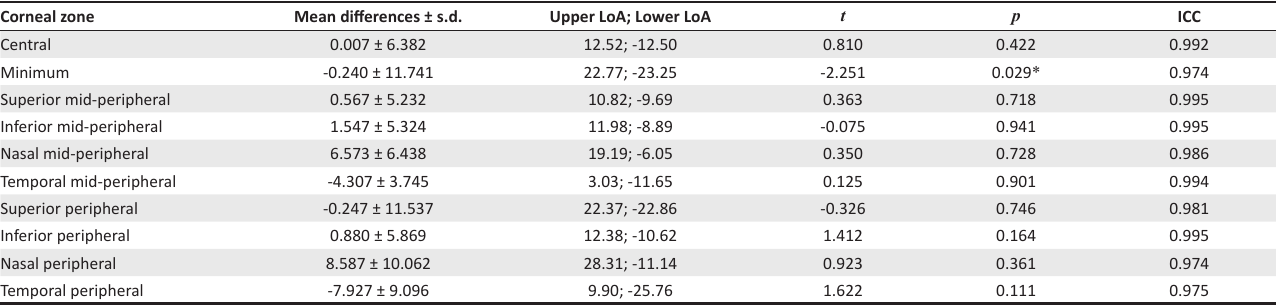
TABLE 2: The between observers mean differences and standard deviations of corneal thicknesses ( µ m) for the right eyes, between observers, Bland and Altman upper and lower limits of agreement, t -values and p -values from linear regression, and the intraclass correlation coefficients. Corneal zone Mean differences ±